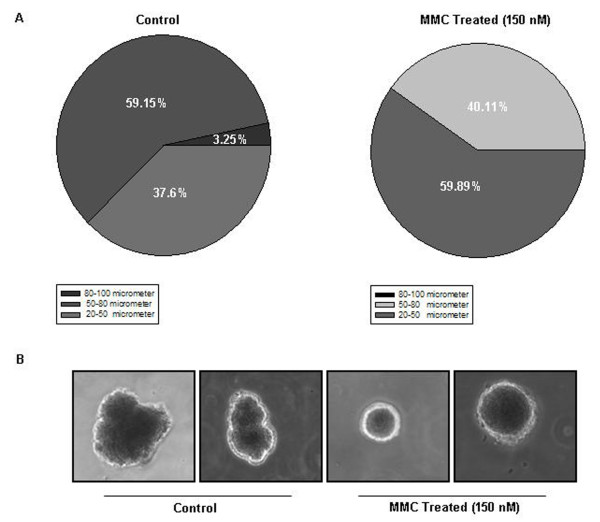
Release of secreted cytotoxic factors diminishes considerably the size of soft-agarose colonies. (A) Pie chart showing percentage distribution of colonies of different mean diameters (colonies >20 μm in diameter were considered) in the soft-agaose plate containing untreated effector HepG2 cells and in the plate containing MMC treated effector HepG2 cells. (B) Photomicrographs of colonies at higher magnification showing diminished growth when MMC treated effector HepG2 cells were added in the center well of soft-agarose plate containing colonies of target cells.